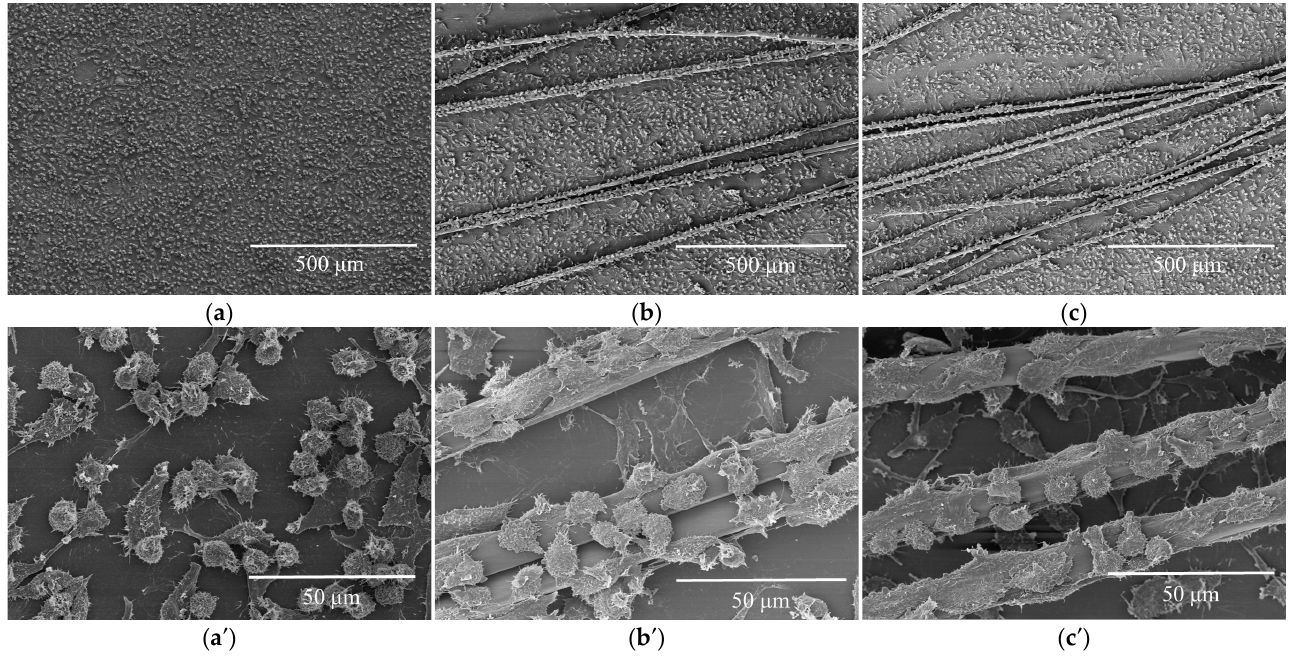
Figure 14. SEM images of L929 cells cultured for 72 h on ( a , a′ ) coverslip, ( b , b′ ) control and ( c , c′ ) CDs-0.50% silk scaffolds.